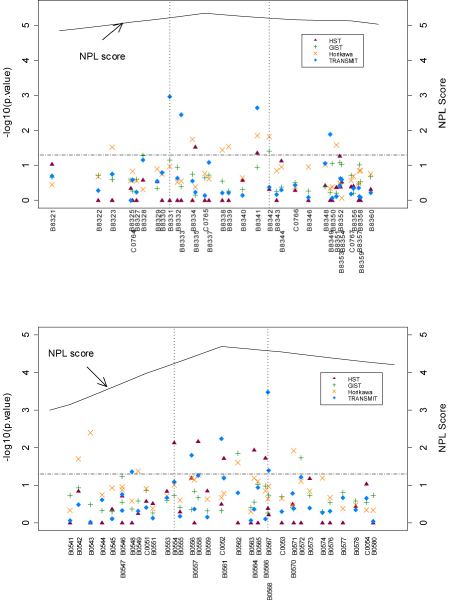
Single SNP results for KA population on chromosome 9 (top) and DA population on chromosome 1 (bottom). The vertical dotted lines specify the haplotype region (HR). Significant SNPs are above the horizontal dotted line (-log100.05).